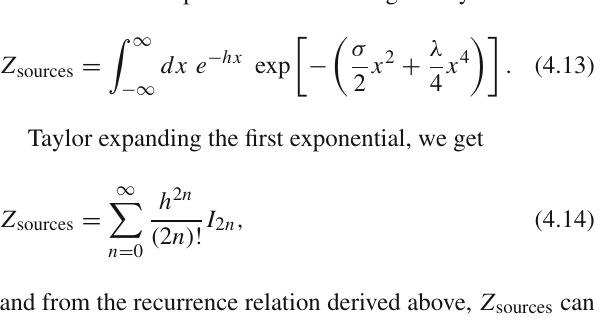
for the critical points φ ± of the action. curves correspond to solution y 1 , orange solid curves to solution y 2 , green solid curves to solution y 3 , and red solid curves to solution y 4 . The shaded regions denote the regions where Re ( S ) ≥